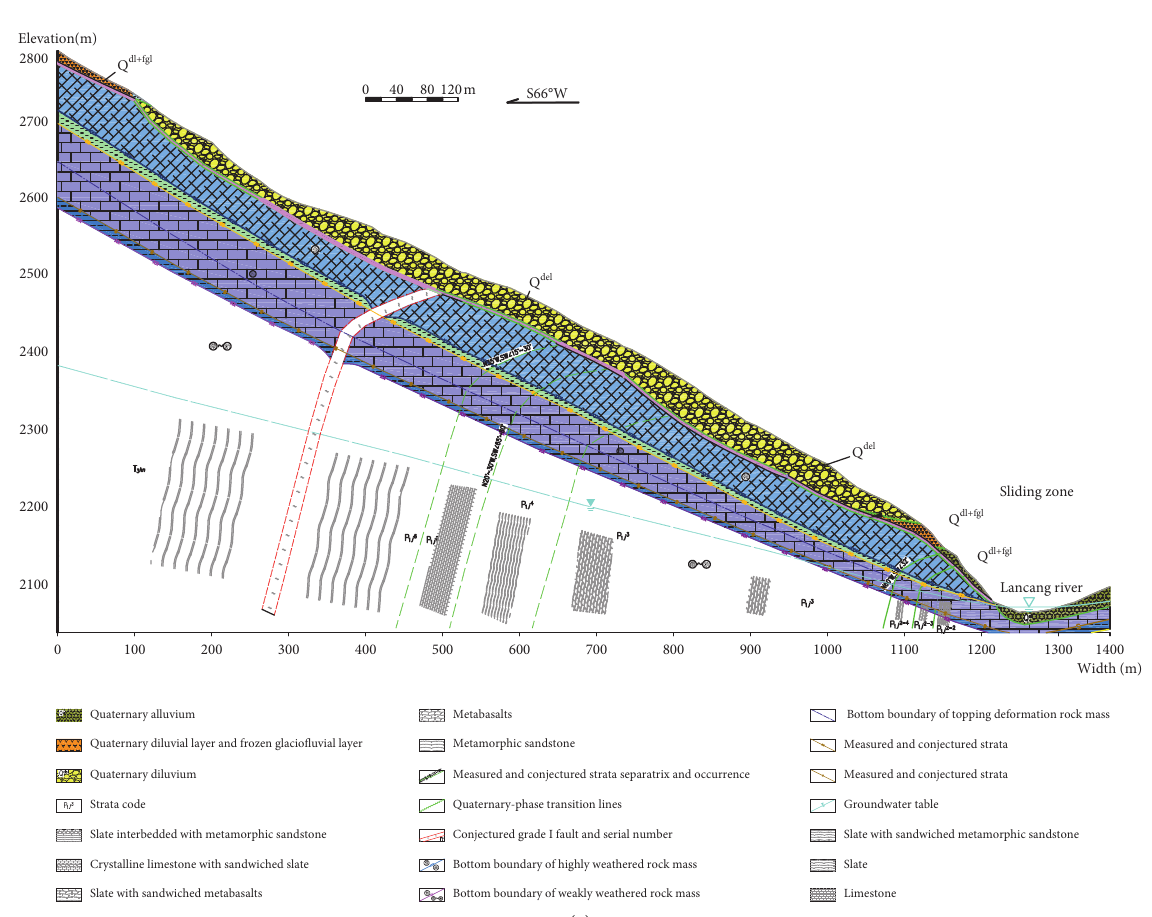
sandstoneMetabasalts